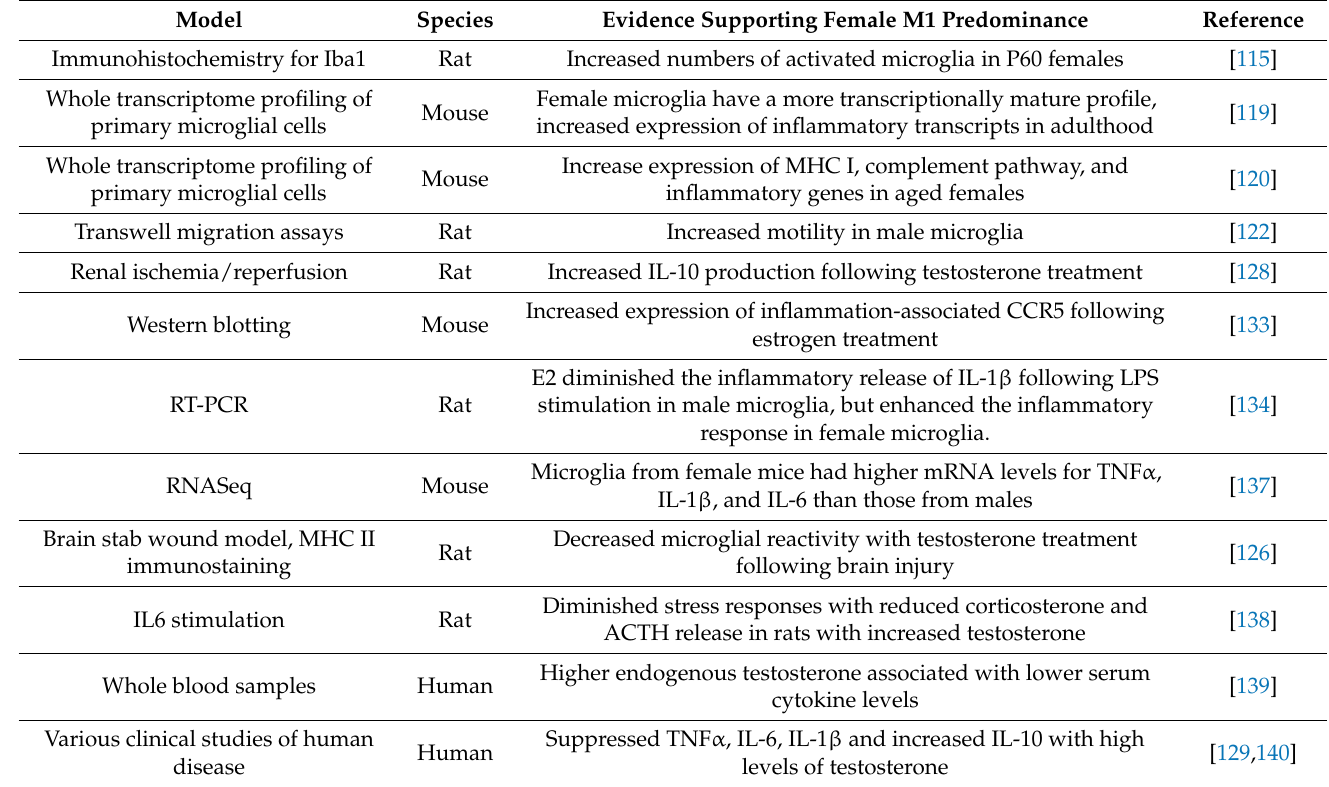
Table 1. Microglial cells are predominantly M1 in females, and predominantly M2 in males.